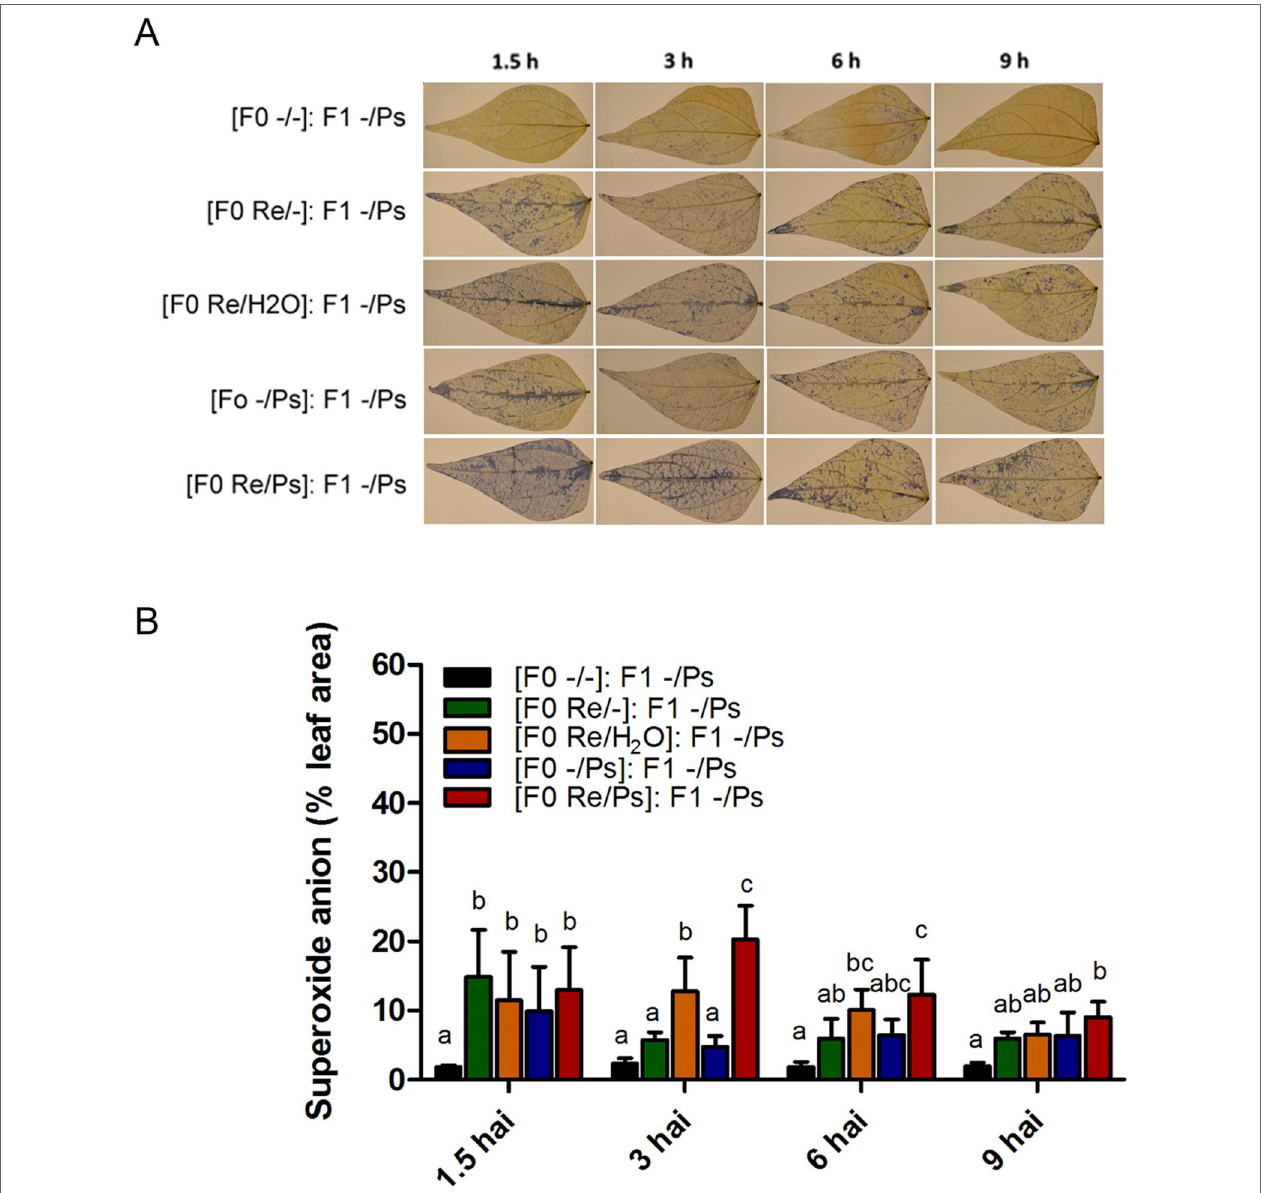
FIGURE 10 | Histochemical detection of superoxide anion in F1 common bean plants at 1.5, 3, 6, and 9 h after infection. Seeds from all F0 plants (-/-, Re/-, Re/ H 2 O, -/Ps, and Re/Ps) were germinated and F1 progeny plants were challenged with the pathogen. (A) Illustrative photographs from three independent experiments on Phaseolus vulgaris leaves from F1 plants after exposure to PspNPS3121. (B) Quantification of O 2− was performed using the protocol described by Juszczak and Baier, 2014. Images were taken using a digital camera Nikon 5500 (Nikon Corp., Tokyo, Japan). Statistical significance was determined using one-way ANOVA followed by Tukey’s test, p < 0.05. Means with the same letter are not significantly